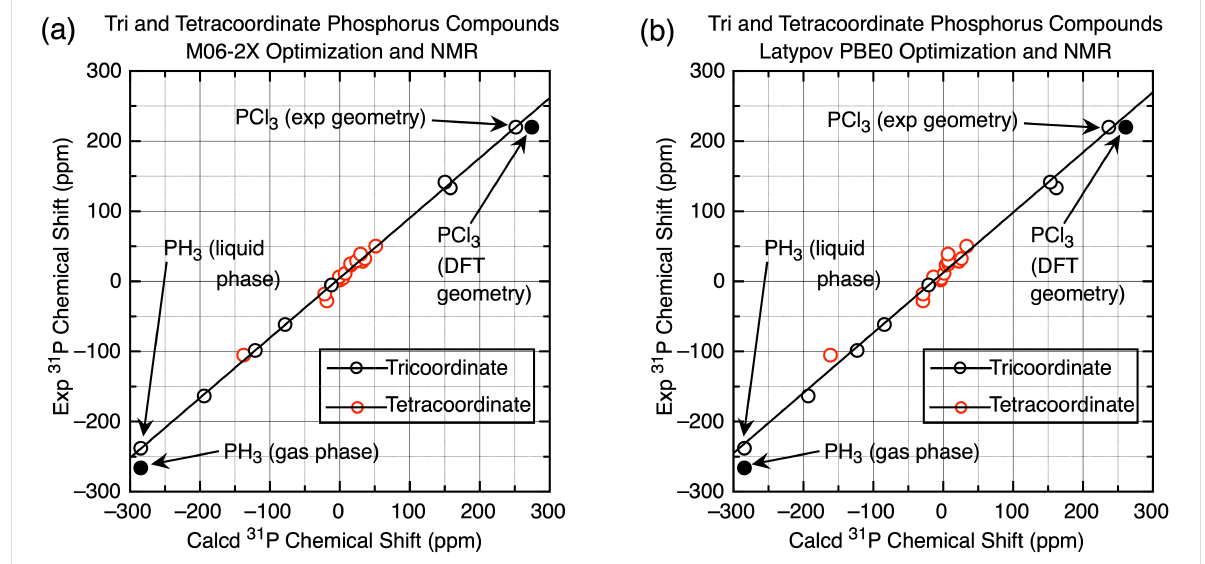
Figure 2: (a) Plot of experimental vs calculated chemical shifts of tri- and tetracoordinate phosphorus compounds (M06-2X optimization and NMR (6-311+G(2d,p) basis set) referenced to H 3 PO 4 , IEF-PCM CHCl 3 solvation). Equation 2 m = 0.855 ± 0.011, b = 4.91 ± 1.27, giving scaled MAD/RMSD = 4.1/5.7 ppm (Equation 3). (b) Plot of experimental vs calculated chemical shifts of tri- and tetracoordinate phosphorus compounds (Latypov PBE0 optimization and NMR (6-311G(2d,2p) basis set) referenced to H 3 PO 4 , gas phase). Equtation 2: m = 0.858 ± 0.019, b = 12.36 ± 2.19, giving MAD/RMSD = 7.8/9.7 ppm. For both (a) and (b), see Table S3 in Supporting Information File 1; the points for PCl 3 (DFT calculated geometry) and PH 3 (gas phase) were not included in the linear